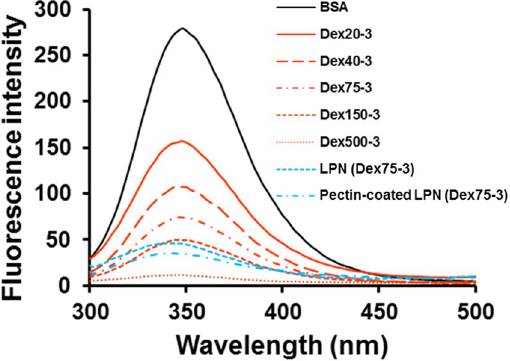
Figure 7. Fluorescence emission spectra of native BSA, selected BSA-Dextran conjugates, LPN and pectin- coated LPN.